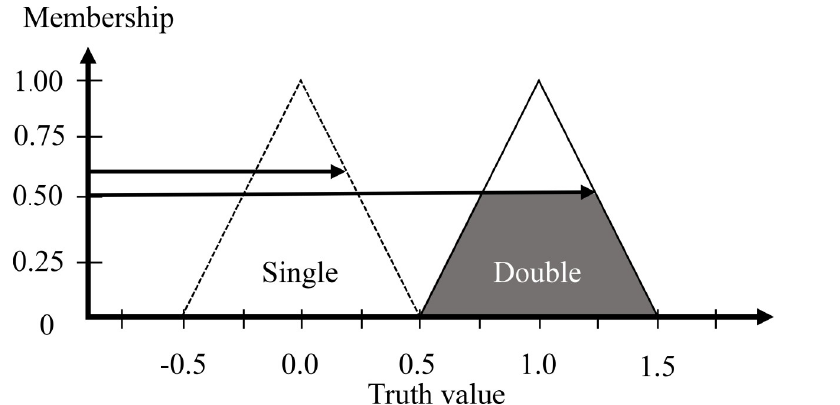
Fig 13. Result of output membership functions of the truth